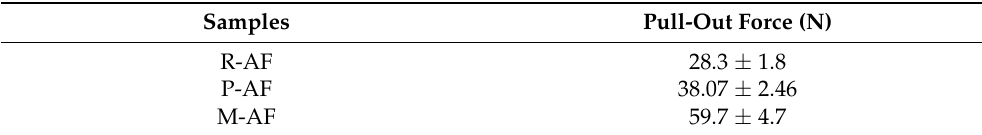
Table 1. The result of the pull-out test for AF/rubber composites.